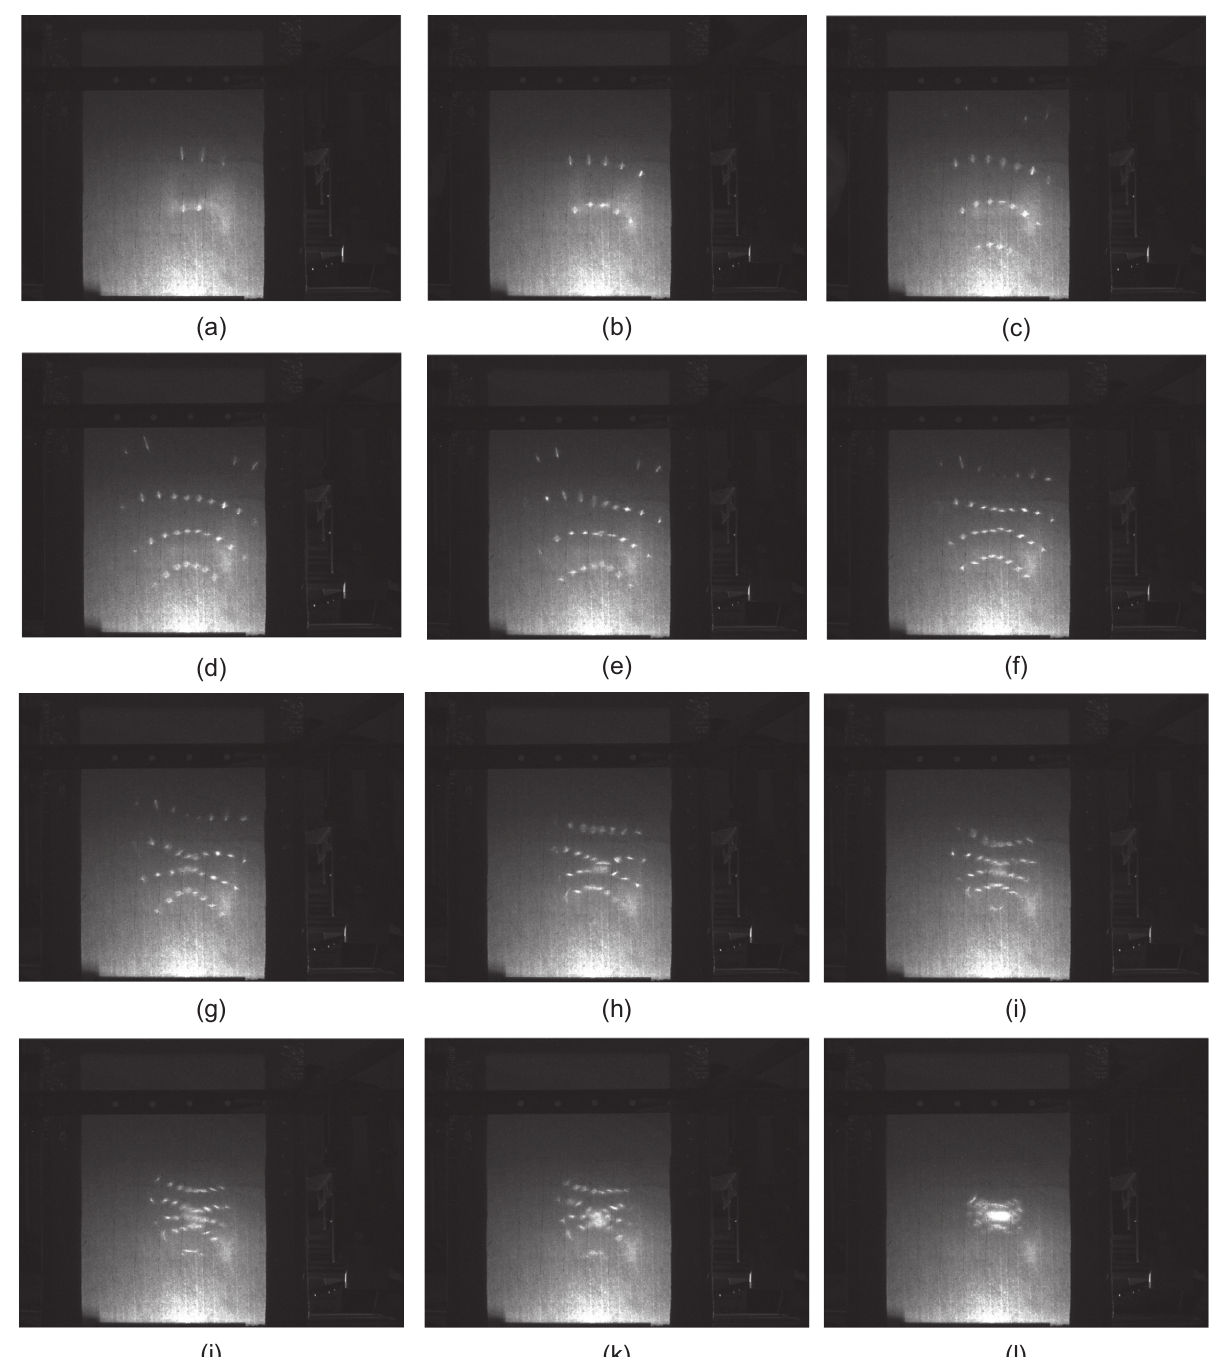
Figure 3: The dots laser pattern change of the weld pool surface at the welding current 70A. (a) t = 2.37 s. (b) t = 3.57 s. (c) t = 7.18 s. (d) t = 13.72 s. (e) t = 14.77 s. (f) t = 16.89 s. (g) t = 17.00 s. (h) t = 17.80s. (i) t = 18.1 s. (j) t = 18.74 s. (k) t = 19.77 s. (l) t = 23.64